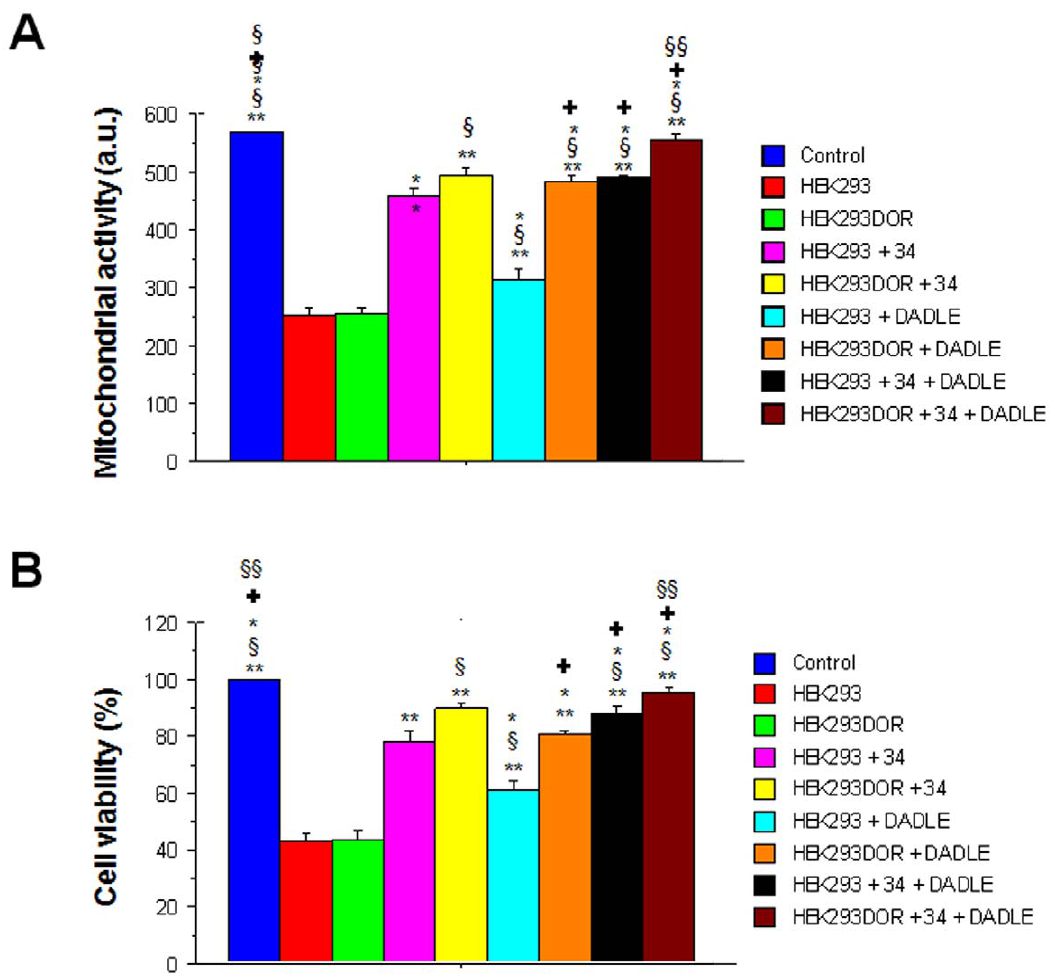
Figure 3. Measurement of mitochondrial activity and cell viability in human embryonic kidney cells (HEK293) and HEK293 cells overexpressing the delta opioid receptor (HEK293DOR). Results revealed that OGD reduced mitochondrial activity and cell viability in HEK293 and HEK293DOR after OGD. Exposure to moderate hypothermia alone, DADLE or combination thereof led to neuroprotection, which was best manifested in HEK293DOR cells. MTT: **p , 0.0001 vs. HEK293 and HEK293DOR, 1 p , 0.005 vs. HEK293 + 34 u C; *p , 0.005 vs. HEKDOR + 34 u C; p , 0.0001 vs. HEK293 + DADLE; 1 1 p , 0.0001 vs. HEK293DOR + DADLE and HEK293 + 34 u C + DADLE. a.u.=absorbance unit.